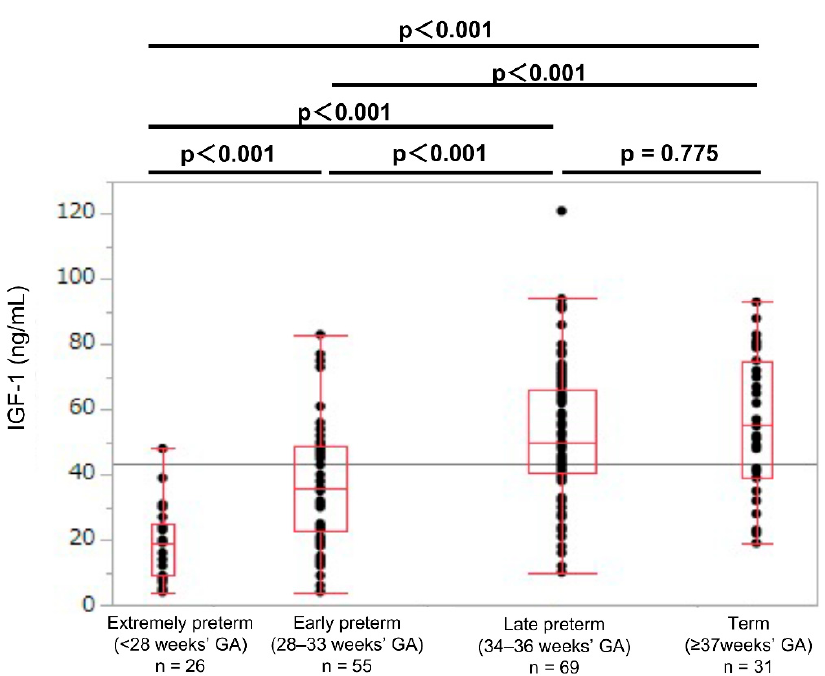
Figure 4. Umbilical cord IGF-1 levels in extremely preterm, early preterm, late preterm, and term non-SGA newborns. GA: gestational age at birth; IGF-1: insulin-like growth factor 1; SGA: small-for-gestational-age.